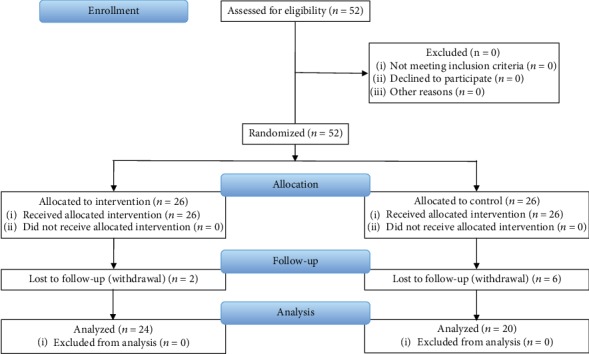
CONSORT flow chart.